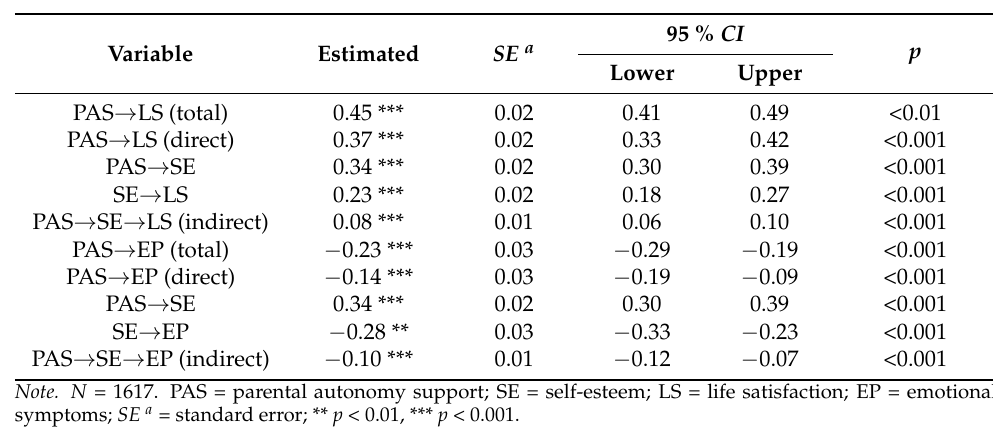
Table 2. Mediation model results for Study 1.